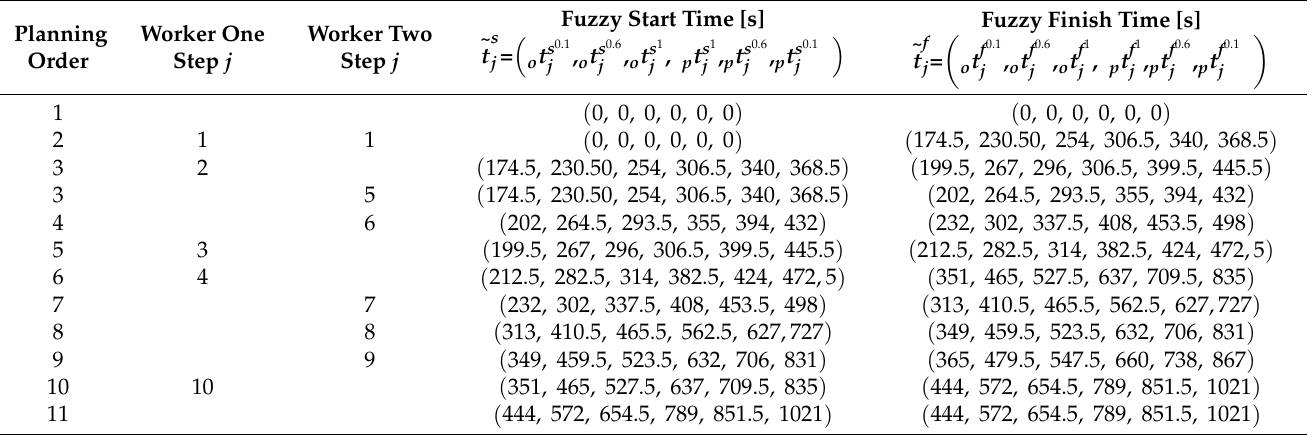
Table A6. Scenario “Two workers, cover together” resulting fuzzy start time ( (cid:101) t s ) time ( (cid:101) t f j